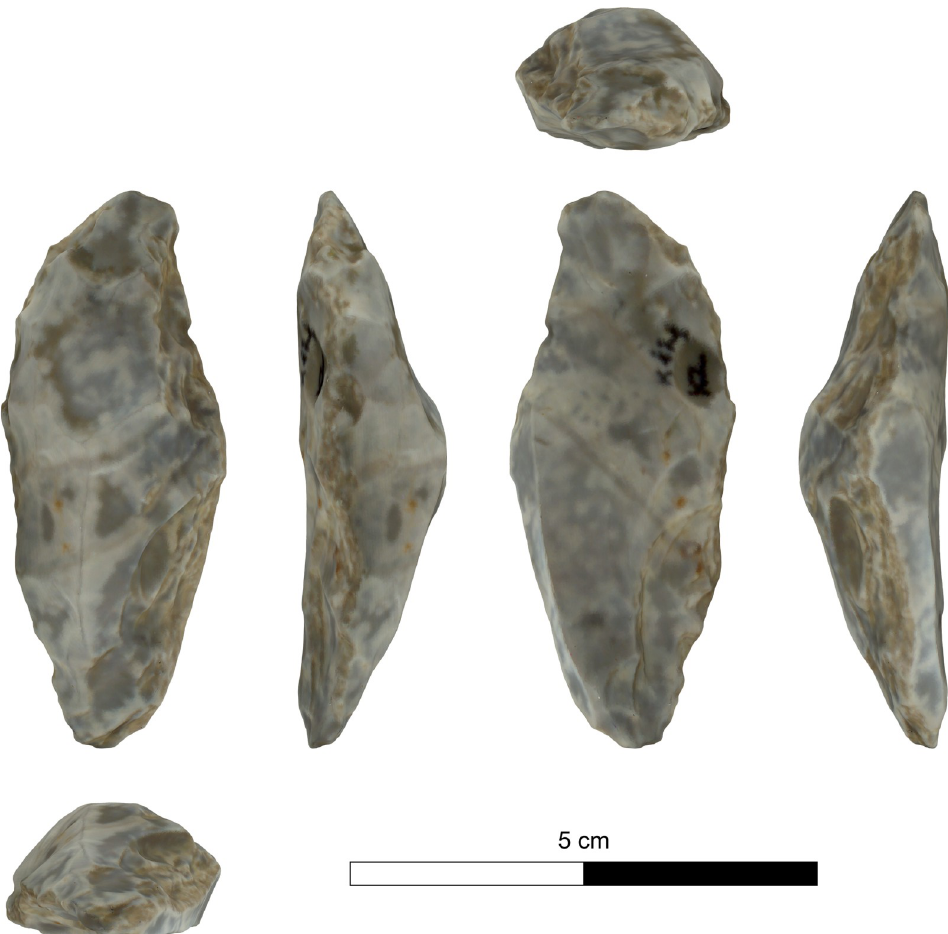
Fig 33. Unfinished biface with preparation for bifacial retouch